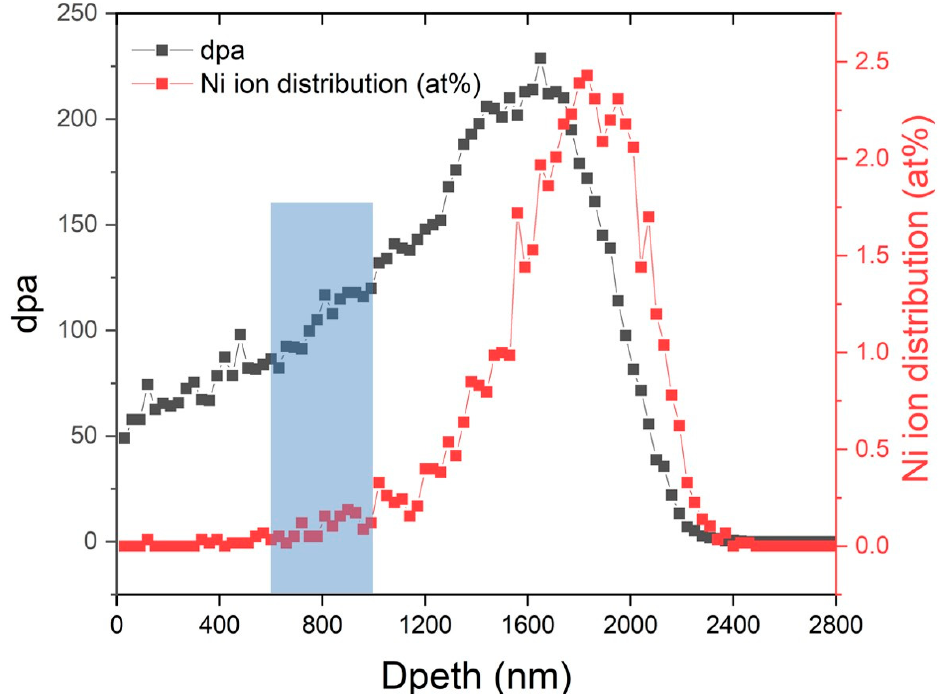
Figure 2. SRIM predictions of dpa damage and Ni concentration (at%) as a function of depth below the surface of the steel. the surface of the